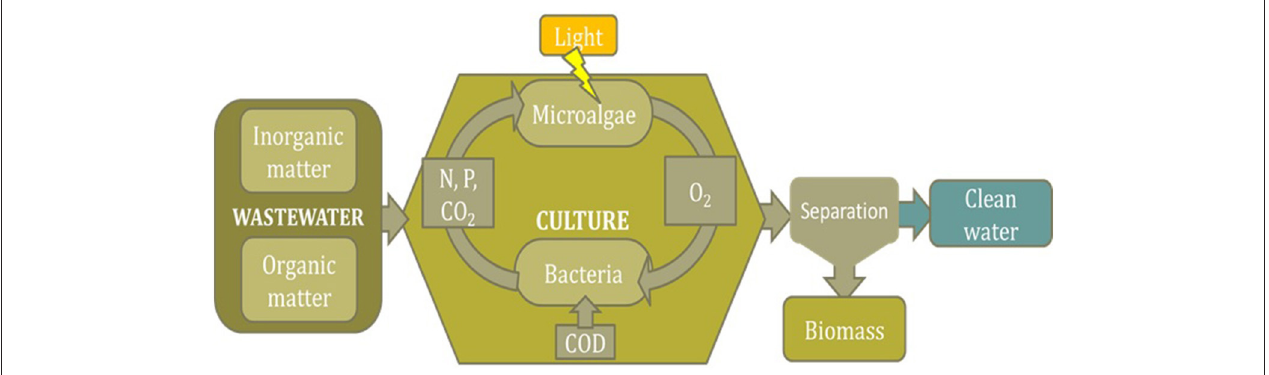
FIGURE 1 | Scheme of the main biological phenomena taking place when using microalgae/bacteria consortia for nutrients recovery from